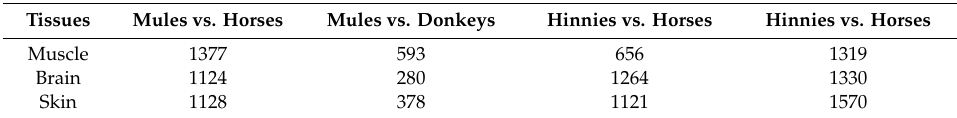
muscle, brain, and skin from mule, hinny, and their parents.